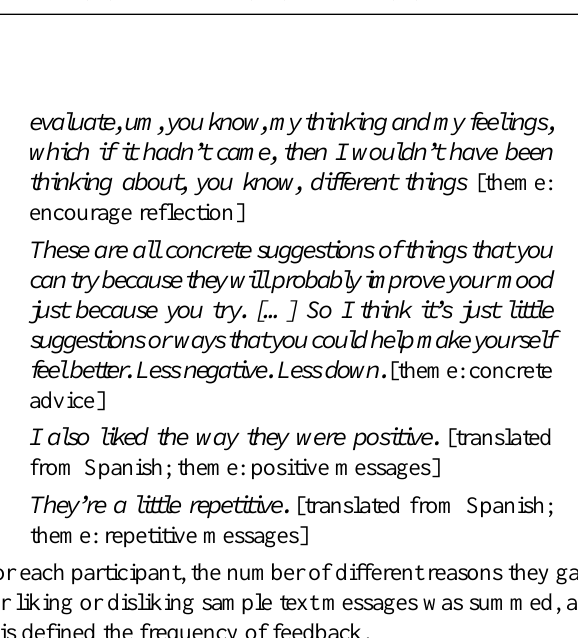
Table 2. Mobile phone digital literacy, as well as domains used to measure digital literacy by English proficiency and health literacy. Subdomains of mobile phone digital